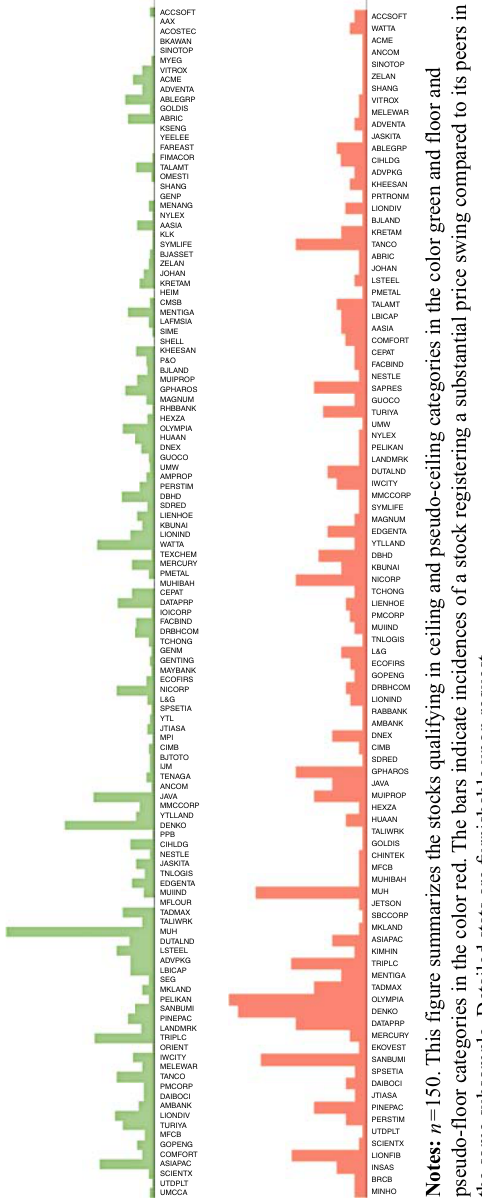
Figure 1. Upward and downward move stocks under